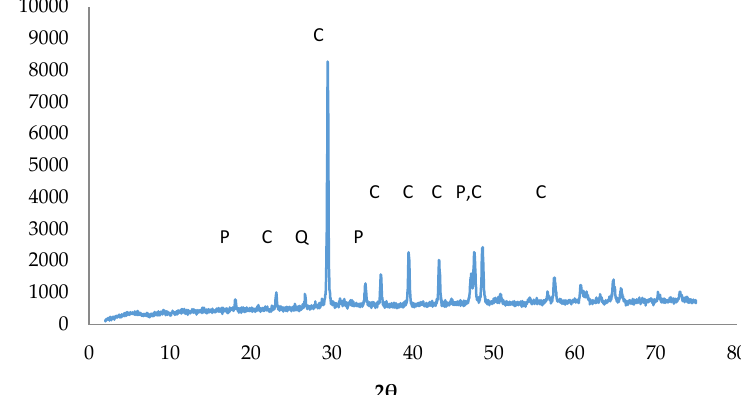
Figure 8. XRD diagram of HR, where C: calcite, Q: quartz and P: portlandite.